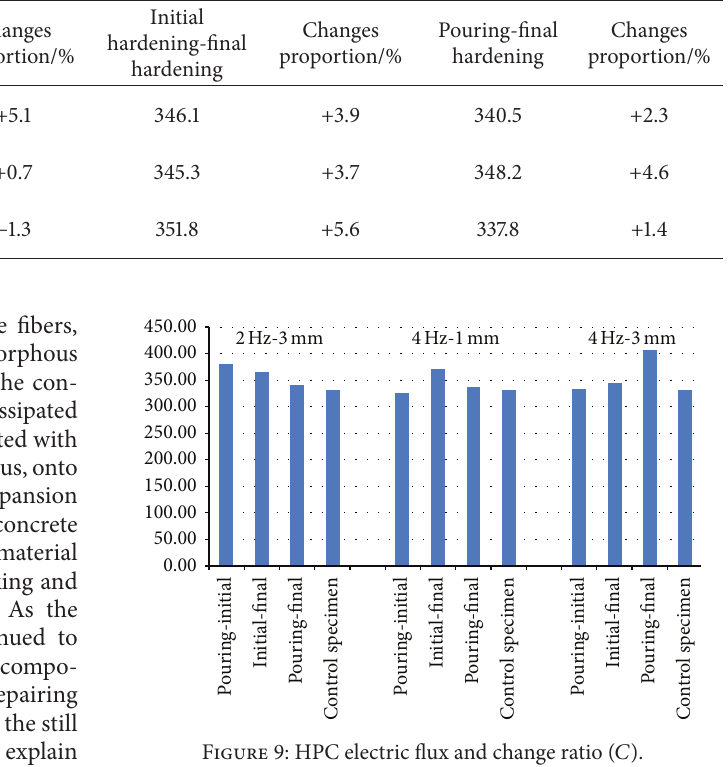
Figure 8: Cross-section of specimen. Table 5: Electric flux and change ratio ( 𝐶 ).